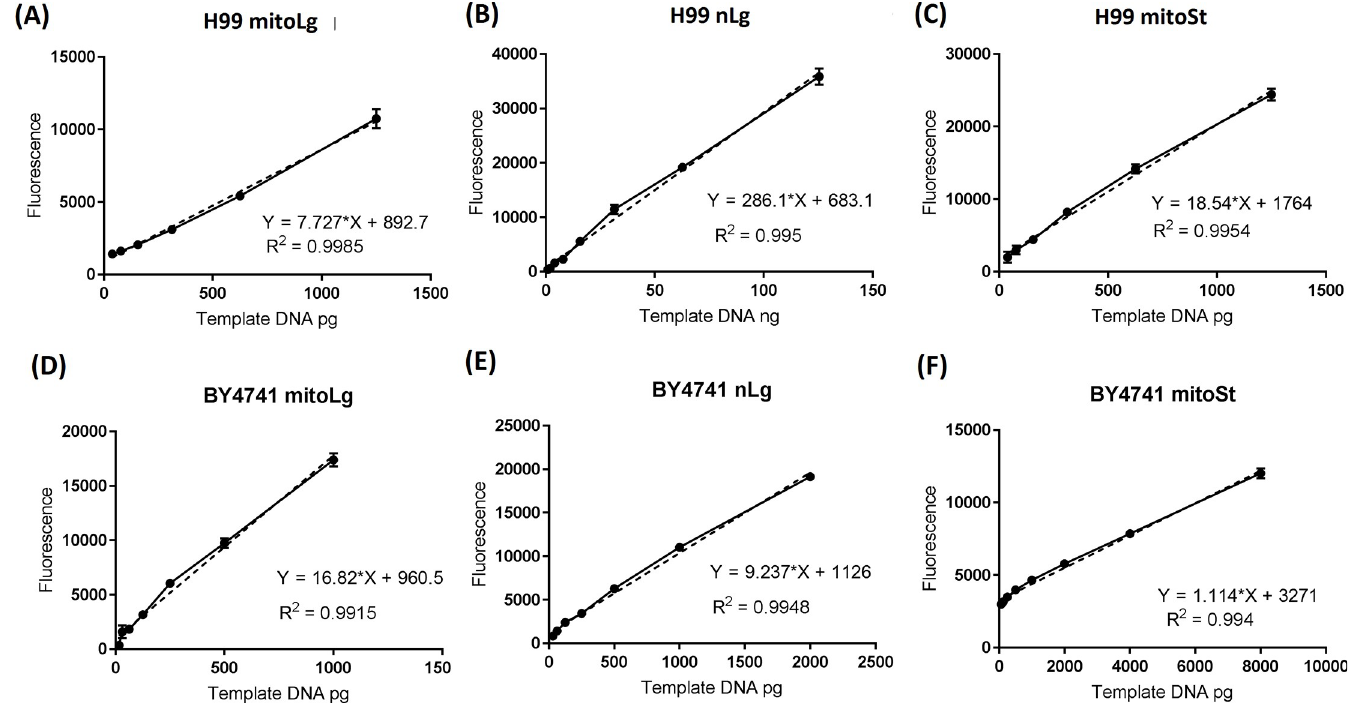
Fig 2. Quantitative amplification of target DNA fragments in LR-QPCR with respect to the amount of template DNA. DNA isolated from C . neoformans H99 and S . cerevisiae BY4741 were serially diluted with nuclease-free water for use in PCR. PCR of each sample was performed in triplicate for 26 cycles (long mitochondrial and nuclear DNA) and 20 cycles (short mitochondrial DNA), and the PCR products were quantified using the PicoGreen assay. (A and D) long mitochondrial DNA fragments from H99 and BY4741, (B and E) long nuclear DNA fragments from H99 and BY4741, (C and F) short mitochondrial DNA fragments from H99 and BY4741. The solid lines connect all of data points. The dotted lines are the linear regression lines. Results were from three independent experiments with triplicate samples in each experiment (3 samples/point/experiment x 3). Mean ±